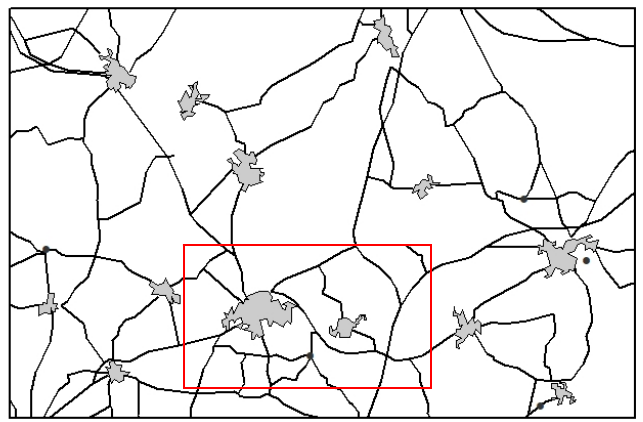
Figure 11. Road network and built areas generalized with Douglas–Peucker simplification algorithm at scale 1: 500,000.